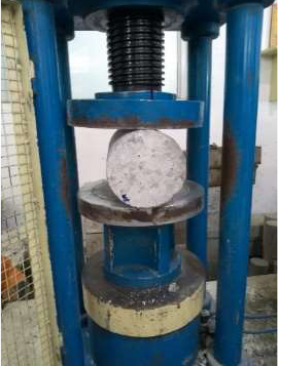
Figure 3. Typical setup of CTM for split tensile test.